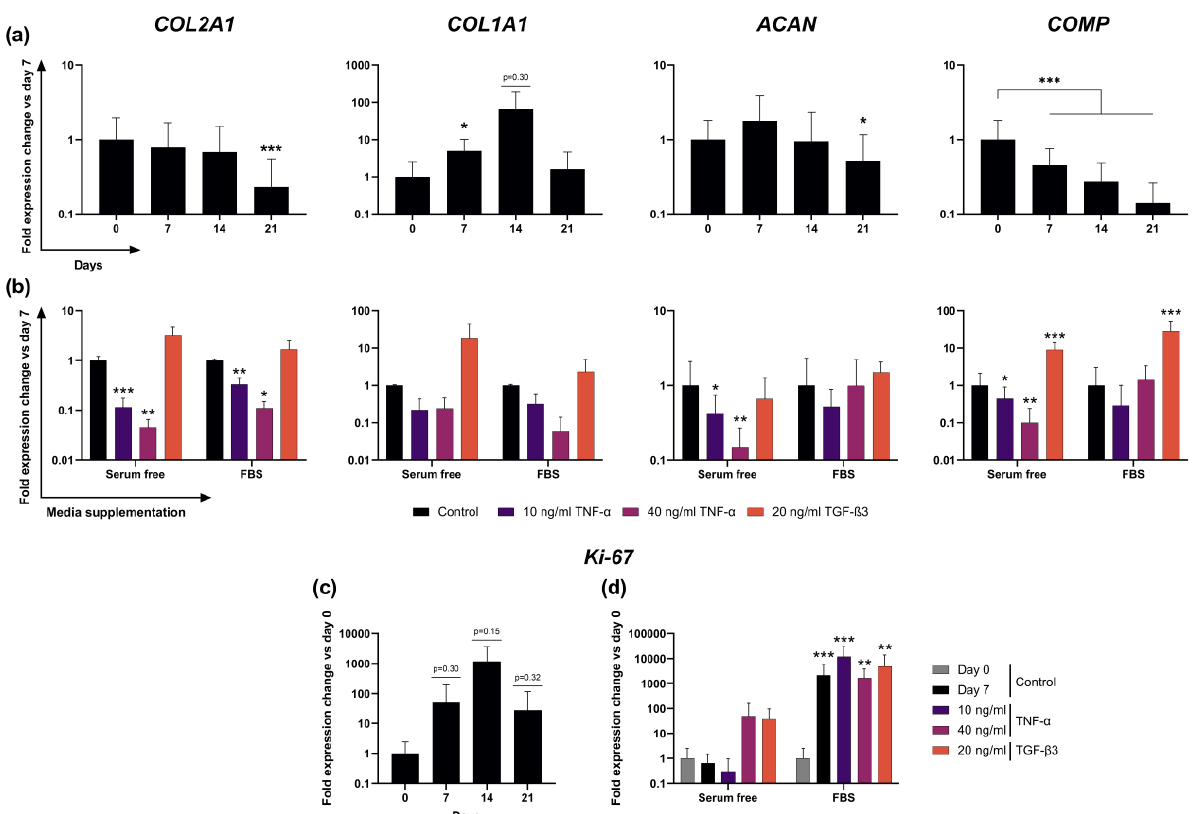
Figure 2. Gene expression analysis of live slice explants via RT-qPCR. ( a ) Gene expression of cartilage-typical markers COL2A1 , COL1A1 , ACAN and COMP in F − cultured slices over three weeks ( n = 12) relative to the day 0 value. ( b ) Gene expression of the same cartilage-typical markers as in A, after 7 days of stimulation with TNF- α or TGF- β 3 and with or without FBS ( n = 6) relative to the control on day 7. ( c ) Expression of proliferation marker Ki-67 in F − cultured slices over three weeks ( n = 12) relative to the day 0 value and ( d ) after 7 days of stimulation with TNF- α or TGF- β 3 and with or without FBS ( n = 6), relative to the day 0 control to show the larger increase in the F + group. Statistically significant differences denoted as * p < 0.05, ** p < 0.01, *** p < 0.001.